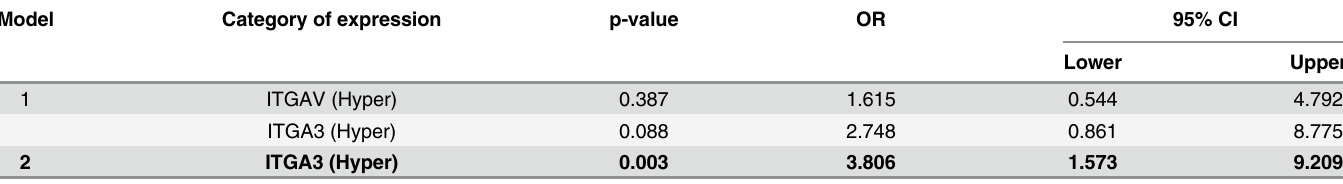
Table 5. Cox regression model for DFS (significant variables